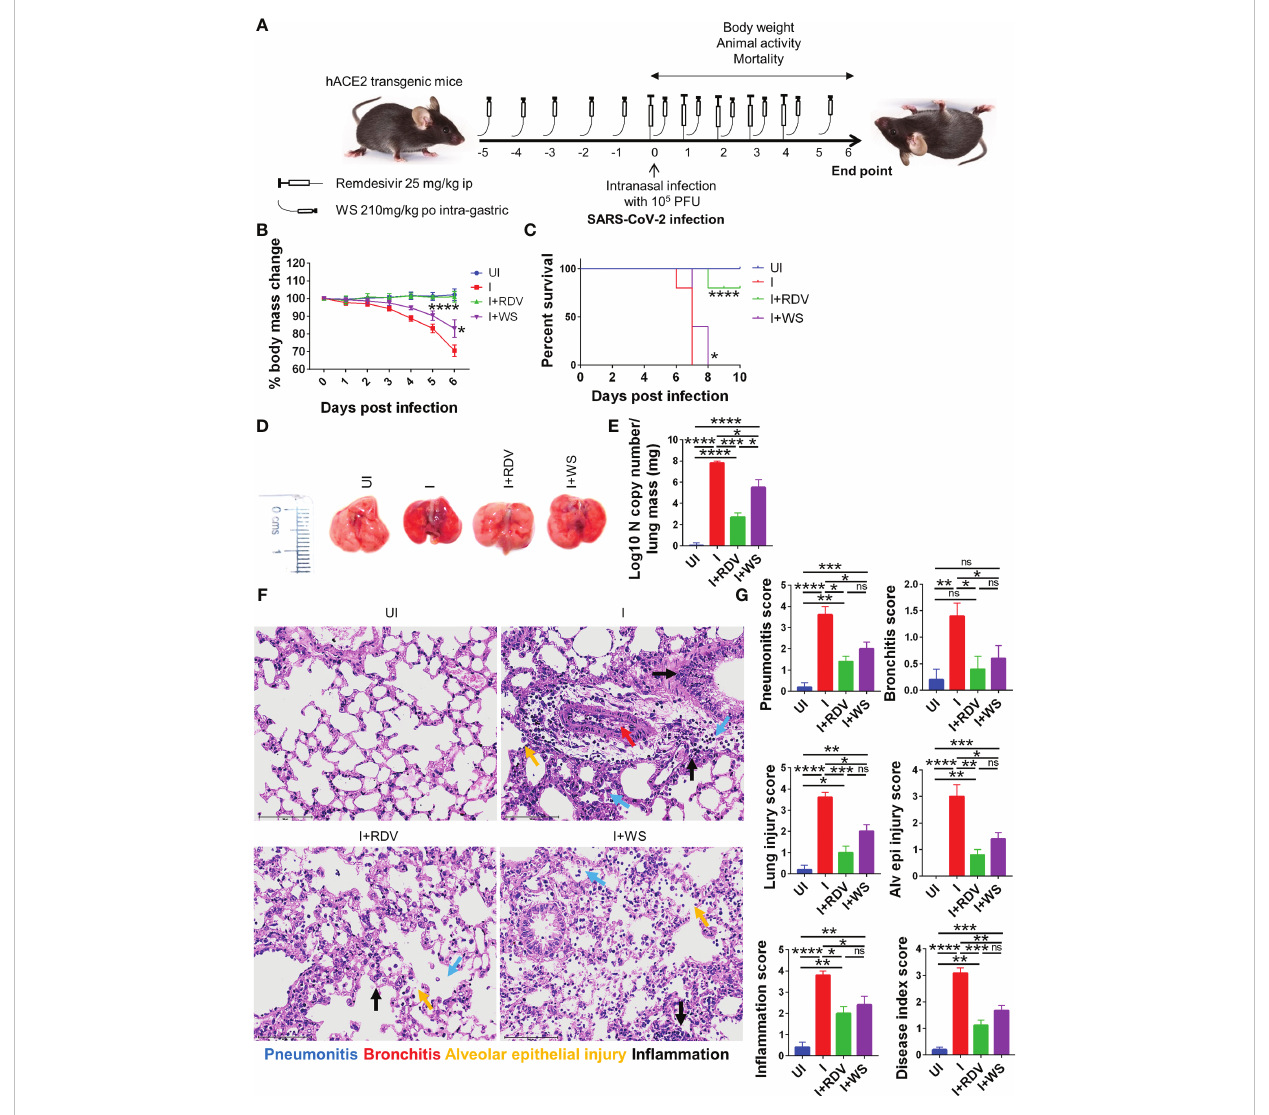
FIGURE 6 Assessment of protective ef fi cacy of WS in acute SARS-CoV-2 infection model of hACE2 transgenic mice. To evaluate the effect of prophylactic treatment of WS on severe SARS-CoV-2 infection, we used hACE2 mice model for acute infection and compared it with RDV control. (A) Schematic representation showing treatment regimen for WS and RDV. Mice were intranasally infected with SARS-CoV-2 and (B) %age changes in body mass and (C) mortality was monitored and plotted. (D) Representative excised lung images 6 days post infection (E) Lung viral load presented as Log10 N copy number (F) Lower lung lobe was used for HE staining (G) and assessed for pathological features by blinded scoring by trained pathologist. For each experiment N=5. One way- Anova using non-parametric Kruskal-Wallis test for multiple comparisons. *P < 0.05, **P < 0.01, ***P < 0.001, ****P <